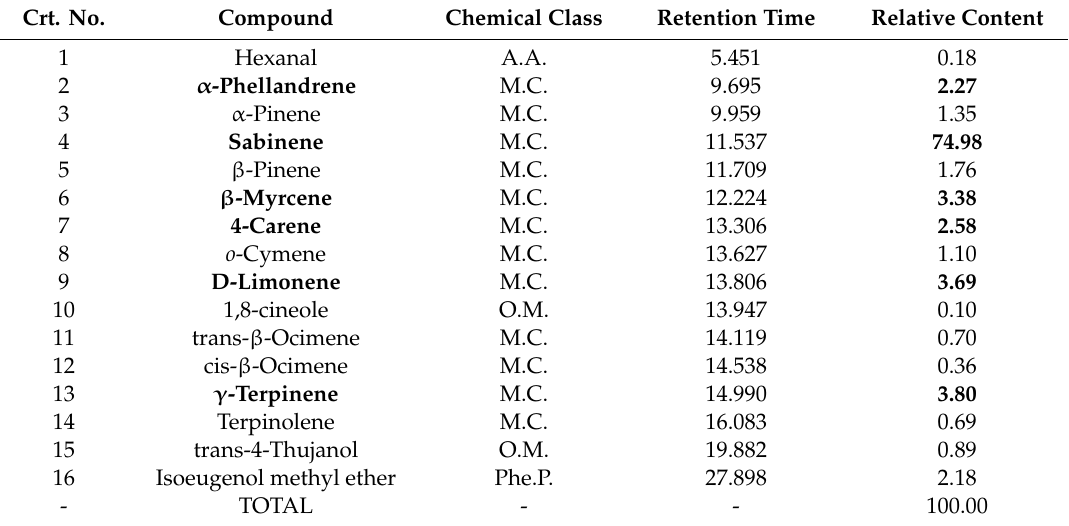
Table 1. Retention times (min) and relative contents (%) of volatile constituents identified in tarragon essential oil.